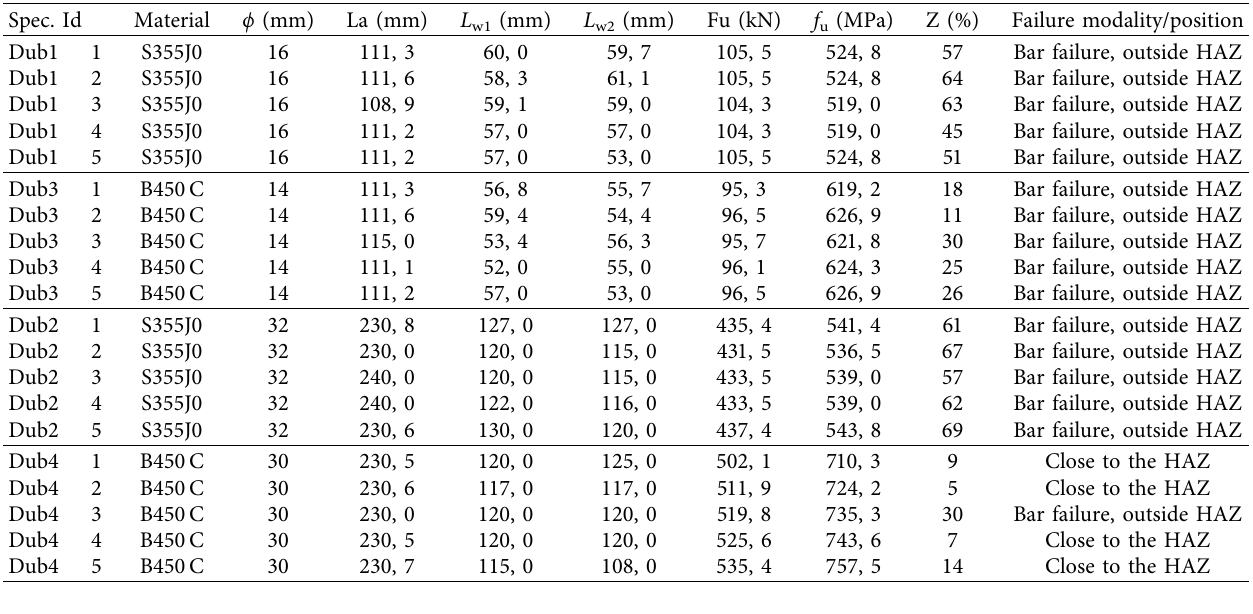
Table 4: Summary of tests’ results on Dub